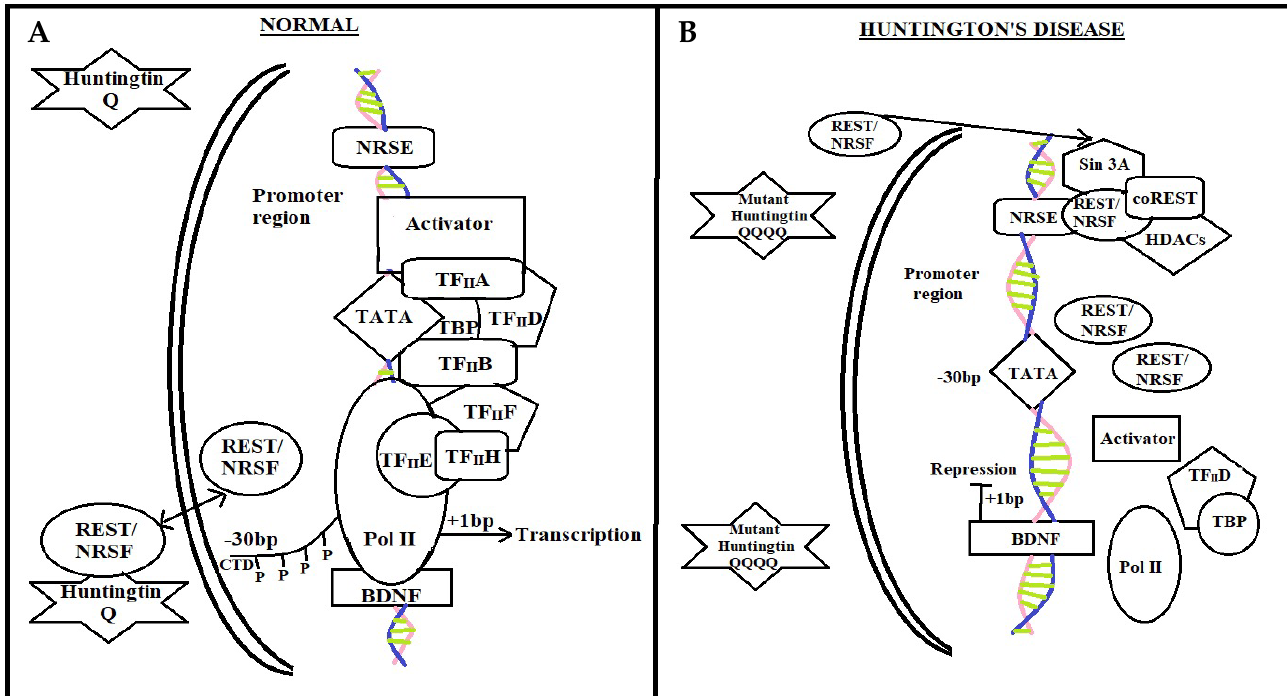
Figure 2. NRSE mediated pathway in a normal individual and diseased patient. In normal individuals, transcription factor REST–NRSF binds to NRSEs in neuronal gene promoters such as in the brain-derived neurotrophic factor (BDNF) gene. By interacting with REST-NRSF in the cytoplasm and lowering its availability in the nucleus to bind to NRSE sites, wild-type htt maintains BDNF synthesis, which is a crucial survival factor for the striatal neurons that die in HD. In these circumstances, activators can bind to the BDNF promoter regions and then recruit the general transcriptional machinery and Pol II, promoting the transcription of BDNF. While in HD, REST-NRSF levels in the nucleus rise as a result of mutant htt’s failure to connect with REST-NRSF in the cytoplasm. In these circumstances, REST-NRSF binds to the NRSE with vigor and stimulates the recruitment of Sin3A-histone-deacetylase complexes (HDACs), which contain histone deacetylase activity for remodeling chromatin into a closed architecture and squelching BDNF transcription. REST stands for repressor-element-1 transcription factor. NRSE stands for neuron-restrictive silencer element.